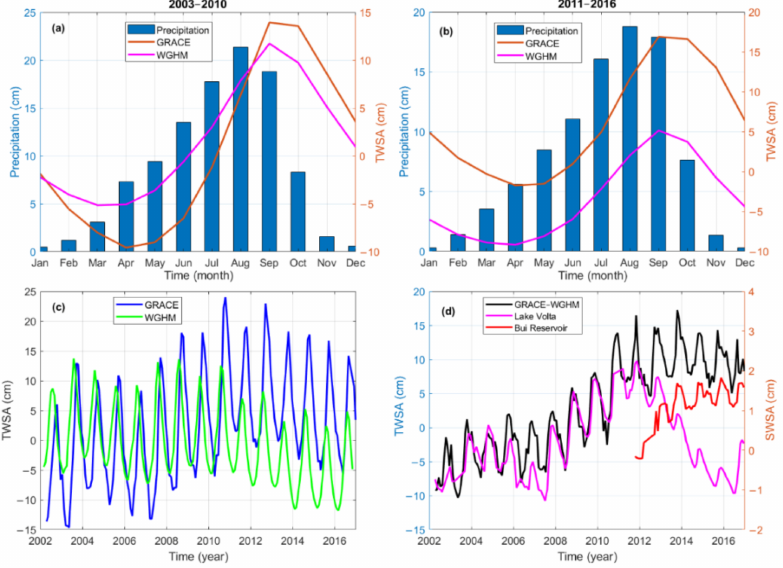
Figure 9. Monthly mean time-series of GRACE-observed TWSA VRB , WGHM-derived TWSA VRB and precipitation derived from Global Precipitation Climatology Centre in the VRB area computed for two periods: ( a ) 2003–2010 and ( b ) 2011—-2016; ( c ) monthly time-series of GRACE-observed and WGHM-derived TWSA VRB over 2002–2016; ( d ) difference between GRACE-observed TWSA VRB and WGHM-derived TWSA VRB , monthly time-series of altimetry-imageries-derived SWSA for both Lake Volta and Bui